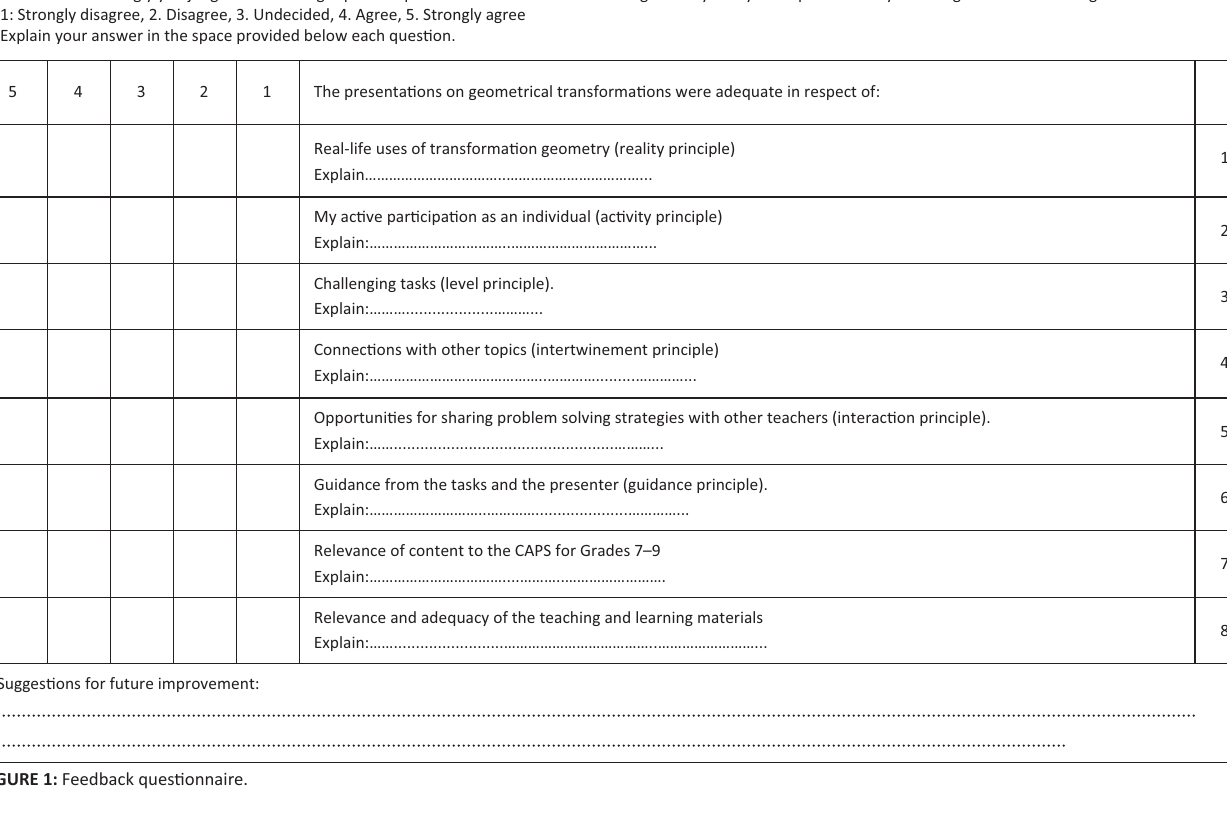
TABLE 2: Item total statistics. Item no.